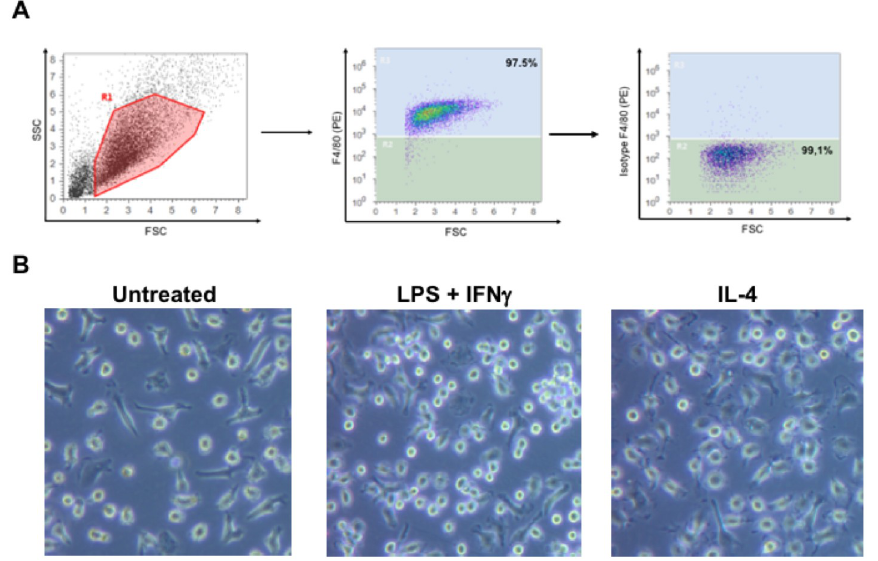
Fig 4. Flow cytometry analysis of BMDMs and differentiation. (A) BMDMs were first gated on FSC and SSC to remove debris and conjugates. Mature BMDMs were defined as F4/80+ subpopulations with the purity displayed as a percentage. (B) After treatment with LPS + IFN γ or IL-4 for 24 hours, BMDMs show different